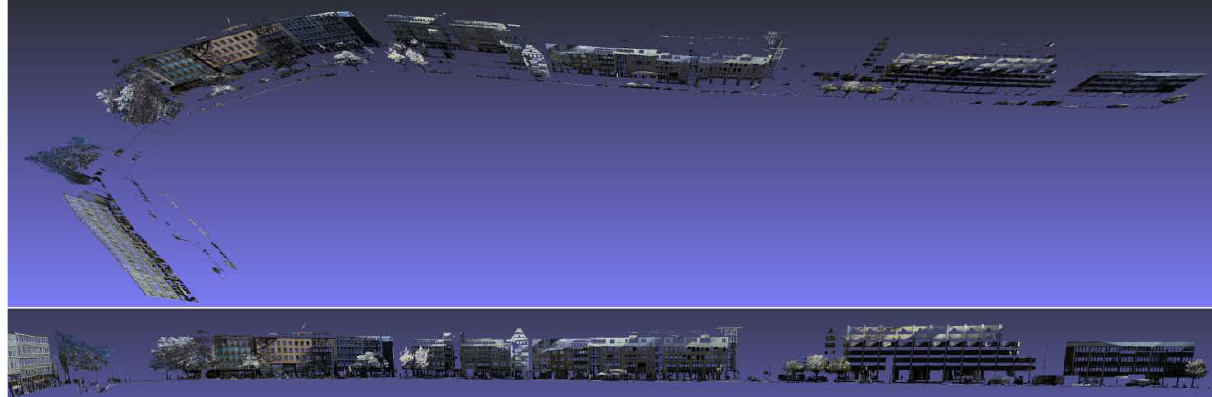
Figure 11. Multi-layer visualization – top view (top) – panoramic front view